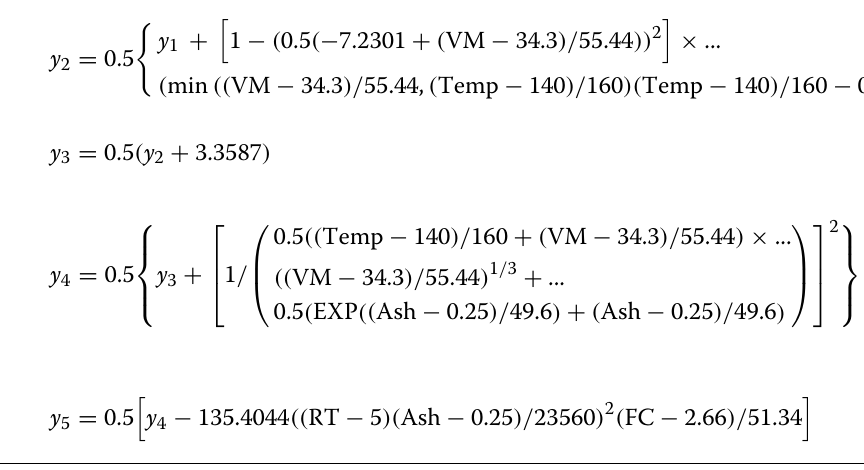
strategy used was the Optimal Evolution. The functional operators (e.g., addition, subtraction, division, multipli- cation, hyperbolic tangent, etc.) were also selected for the respective MY, EY, and HHV. The maximum fitness was used as the stop condition. The model was